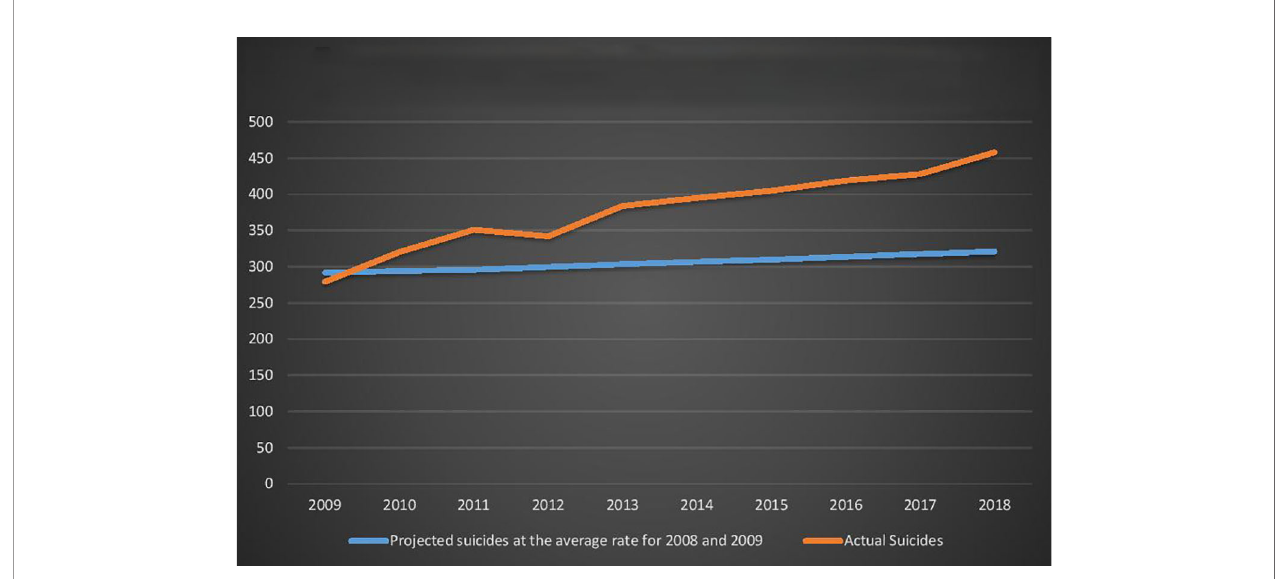
FIGURE 2 | Young Australians (aged 0-24 years) Actual Suicides and Projected Suicides at the 2008 and 2009 average